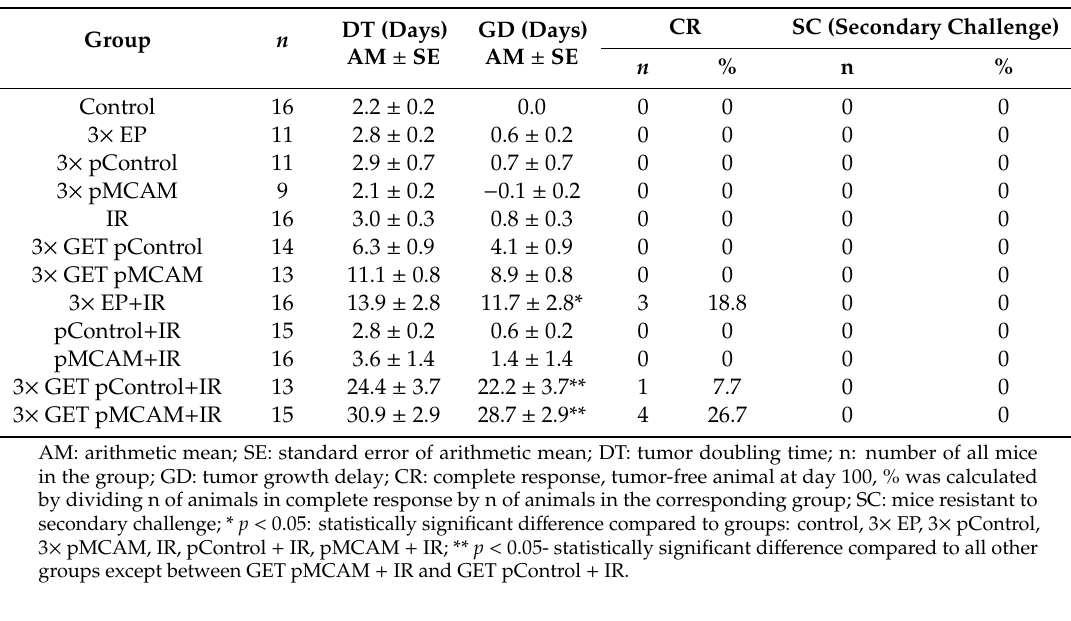
Table 2. The antitumor response of TS / A carcinoma after di ff erent treatment modalities.